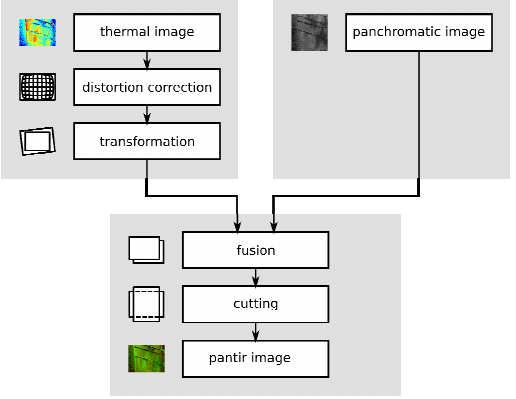
Figure 2. Flowchart that summarizes the preproccesing steps.